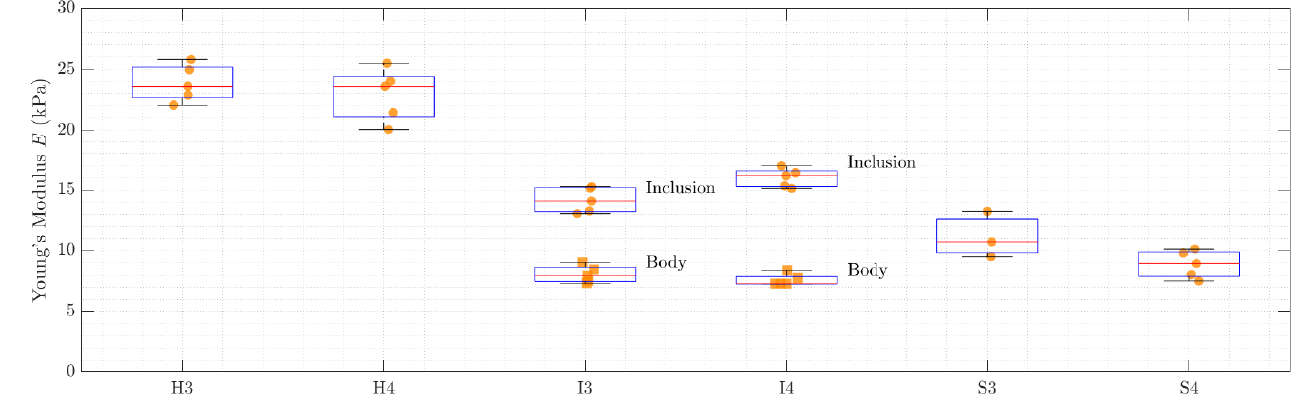
Figure 21. The elastography results for the six specimens. The values indicated here were calculated according to the regions of interest.